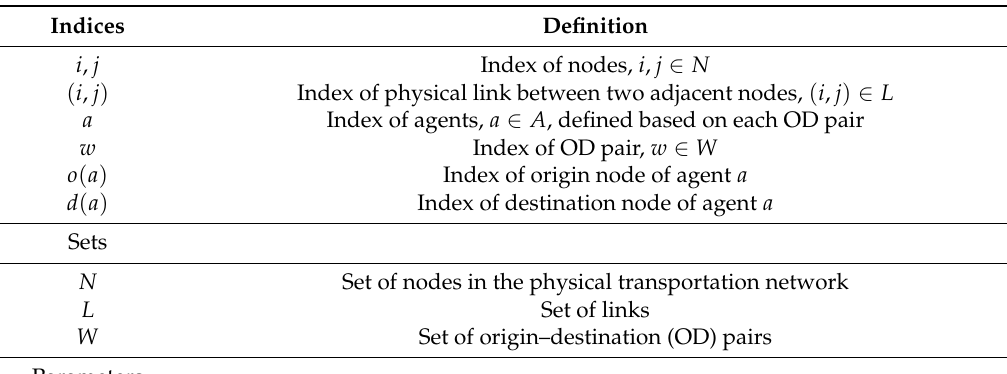
Table 1. Indices, sets, parameters, and